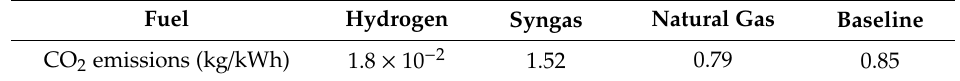
Figure 17. CO 2 emissions during year (diurnal hours). Table 5. Year-averaged CO 2